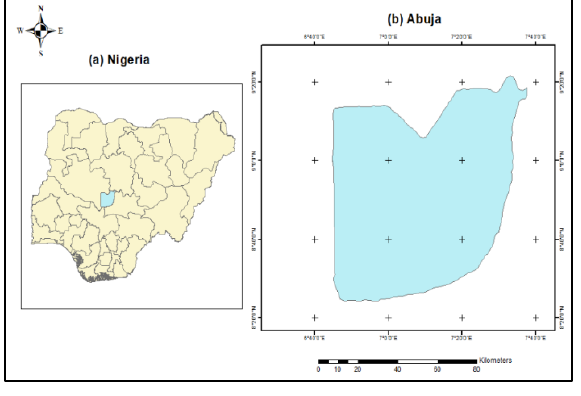
Figure 1. The location of the study area